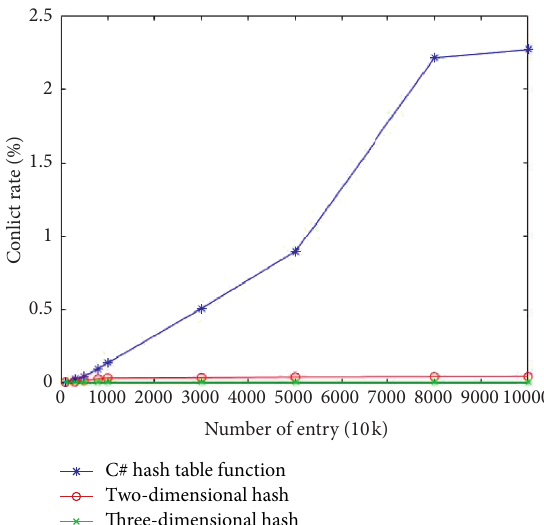
Figure 10: Comparison of conflict of two-dimensional, three-dimensional, and C# hash table